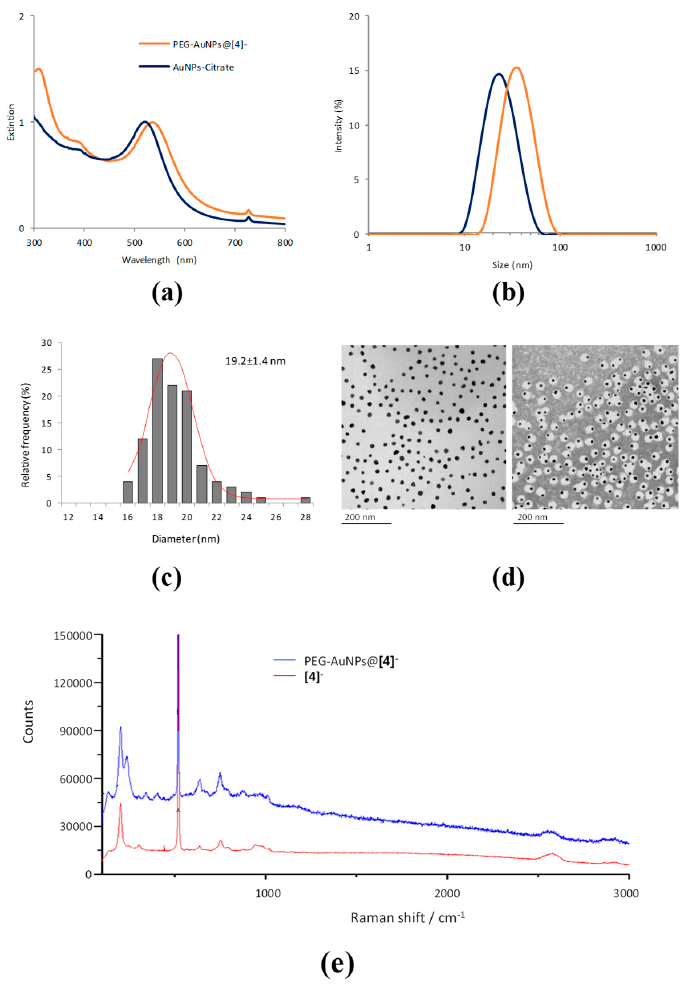
Figure 1. ( a ) UV-Vis spectra corresponding to citrate stabilized AuNPs (AuNPs-Citrate, blue, λ max = 524 nm) and PEG-stabilized AuNPs@[ 4 ] − (PEG-AuNPs@[ 4 ] − , red, λ max = 531 nm for the gold plasmon; λ max = 310 nm corresponds to compound [ 4 ] − ); ( b ) Size distribution ranges as determined by DLS (volume distribution) for AuNPs-Citrate and PEG-AuNPs@[ 4 ] − (same colour code as in ( a )); ( c ) Particle size distribution of PEG-AuNPs@[ 4 ] − as determined by TEM; ( d ) representative TEM images of AuNPs-Citrate and PEG-AuNPs@[ 4 ] − ; ( e ) Raman spectra for PEG-AuNPs@[ 4 ] − and compound [ 4 ] − .